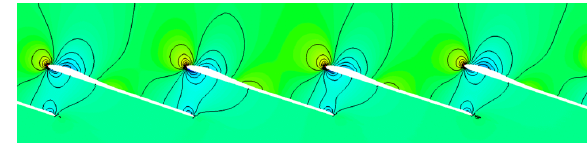
Figure 13. Instantaneous pressure field due to blade torsion